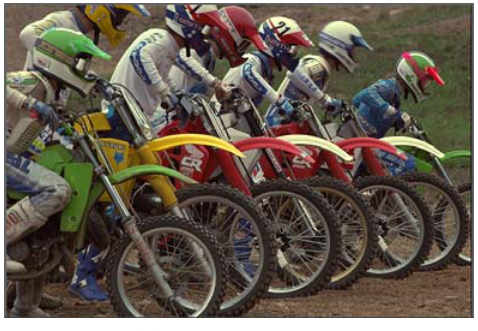
Figure 18. (a) Original Image. (b) Noisy image. (c) Cropped and zoomed noisy image detail. Cropped and zoomed noisy image detail filtered with: Multistage median-1 filter(d), Multistage median-3 filter (e), proposed